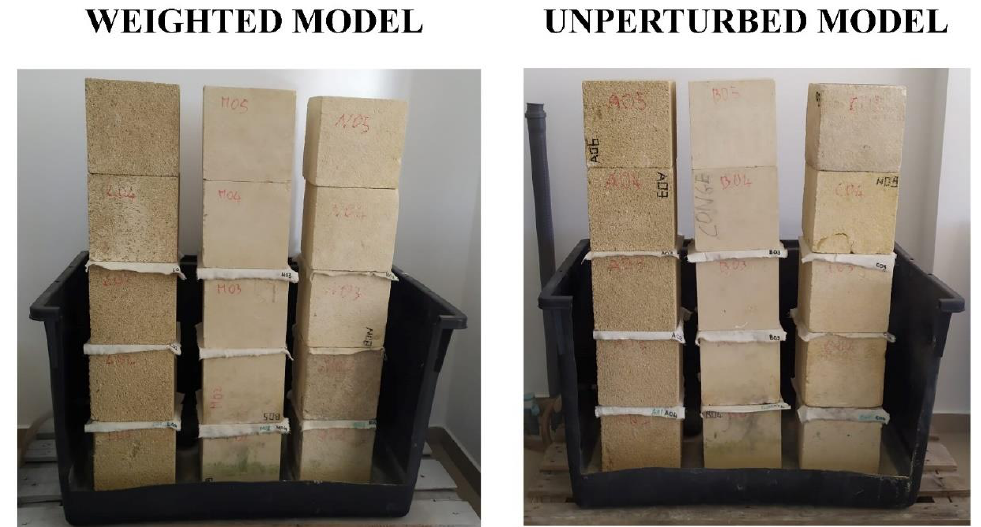
Figure 3. From left to right: carparo (C.), Lecce stone (L.S.), and tuff (T.). Initially, once the blocks were positioned in the tank, they were left to dry for 24 h, to allow the achievement of thermodynamic equilibrium with the surrounding environment, and thus, to allow the achievement of the physiological mass ( m f ) of the various blocks. Subsequently, the basins were filled with water. The monitoring was carried out starting from the initial moment when the specimens were dry, and water was added for the first time into the basin. A periodic replenishment of water in the basin, to maintain a constant level of immersion of the base of the columns (about 3 cm), was done by using a 5 L tank. By weighing the blocks periodically, the wet mass ( m u ), and thus, consequently, the percentage of water absorbed U f at different heights, was determined using Equation (7): 𝑈 𝑓 = 𝑚 𝑢 − 𝑚 𝑓 𝑚 𝑓 100 (7) Through continuous monitoring, based on a combination of visible and thermographic shots and weighing at defined time intervals, it was possible to obtain qualitative and quantitative results of the water propagation inside the columns. The monitoring period was from 6 September 2018 to December 2018. Specifically, on September 6 the dry specimens were placed inside the basin, exactly 24 h before the start of the measurements. Then, after 24, the first weighing was performed on September 7, to detect the physiological mass of the dry specimens. Then, after the weighing operations and having repositioned the various specimens, the basin was filled with water. After two hours, the first thermographic images were acquired. From September 7 to 14, weighing operations of the wet specimens were performed weekly, from 14 September 2018 to 21 December 2018, bi-weekly. Table 5 shows the dates and the quantity of water supplies during the analysis period. Table 5. Water replenishment. Date